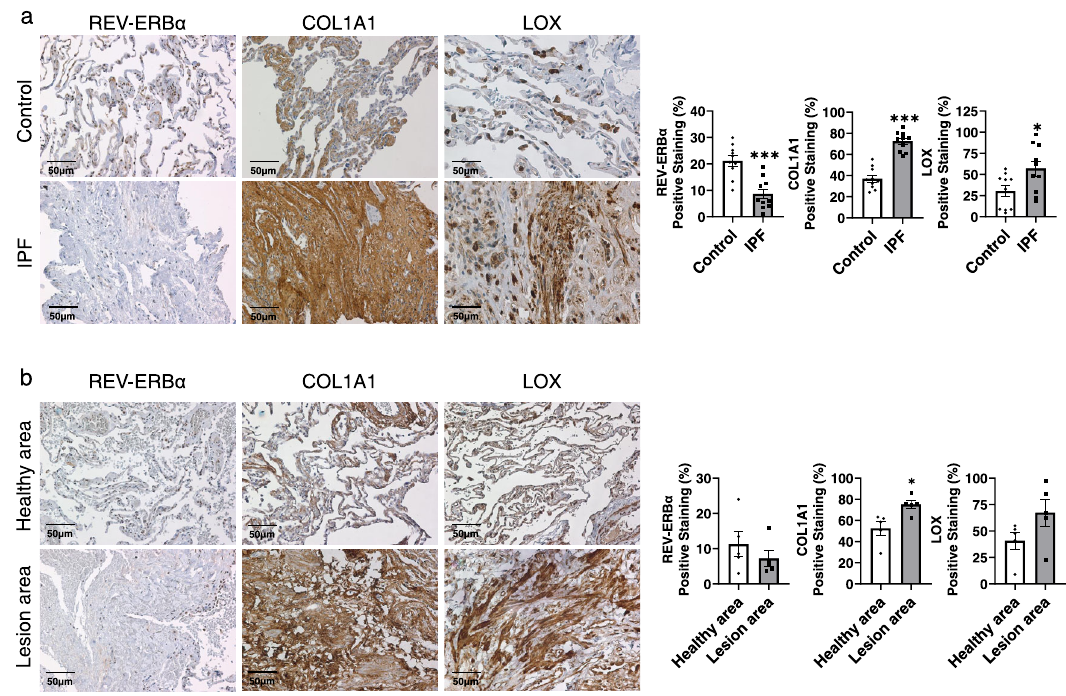
Fig.1|DecreasedREV-ERB α proteinabundanceandincreasedproteinlevelsof COL1A1and LOXinIPFlungscomparedtohealthycontrol. Healthycontroland IPF formalin fi xed-paraf fi n embedded (FFPE) lung samples were purchased from Origene Inc. Healthy controls contained 100% normal lung architecture with 85% alveolisurface area.IPF patient samples containedatleast 50% lesion surfacearea. The protein abundance of REV-ERB α , COL1A1, and LOX were visualized and